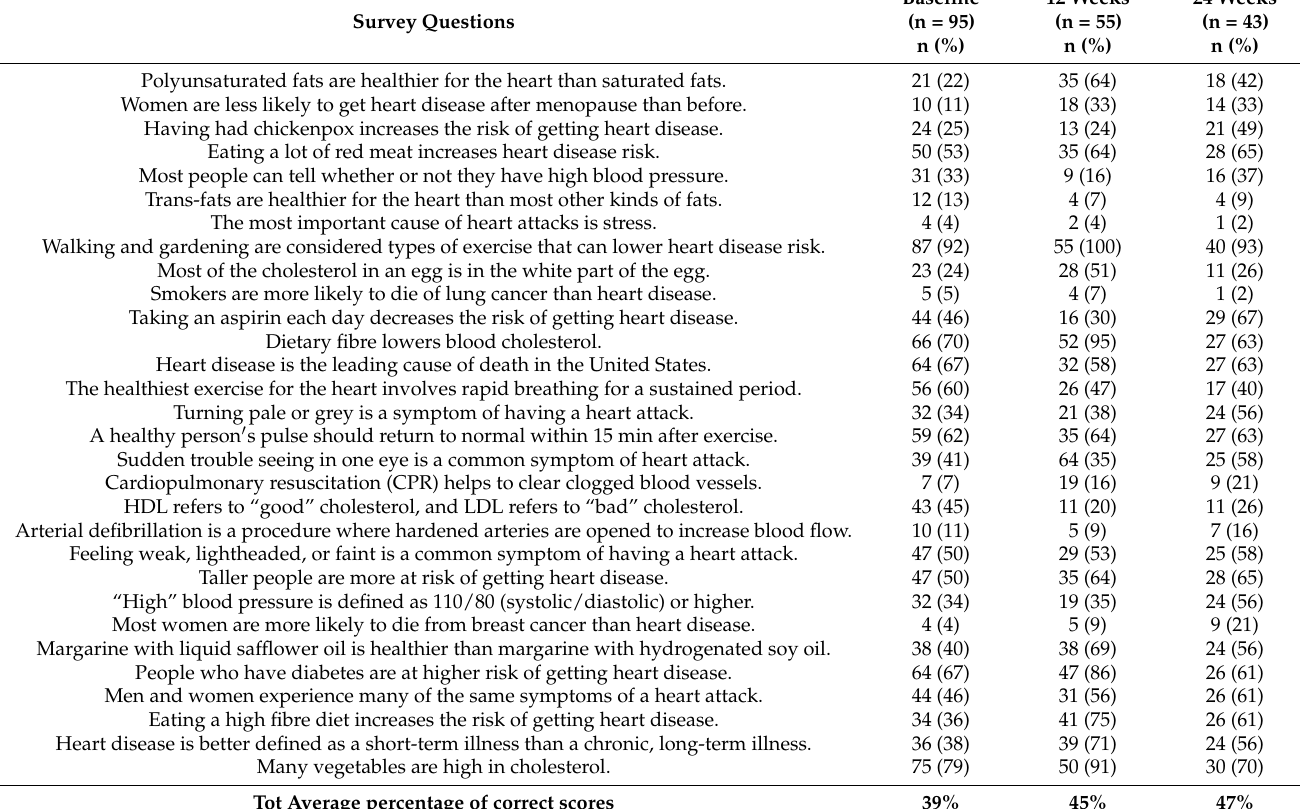
Table 4. Number and percentage of participants scoring correct answers for the heart disease survey at the three time